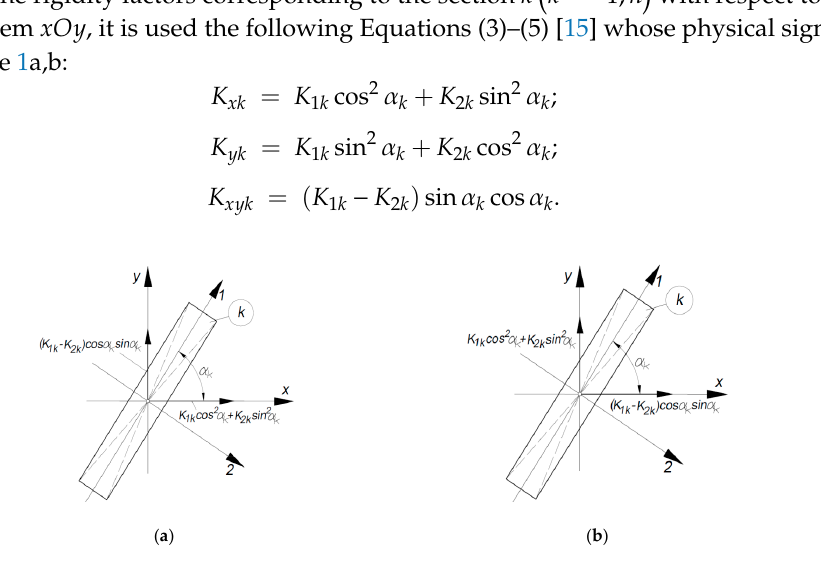
Figure 1. The rigidity factor corresponding to a unitary displacement applied on: ( a ) x axis, and ( b ) y axis.